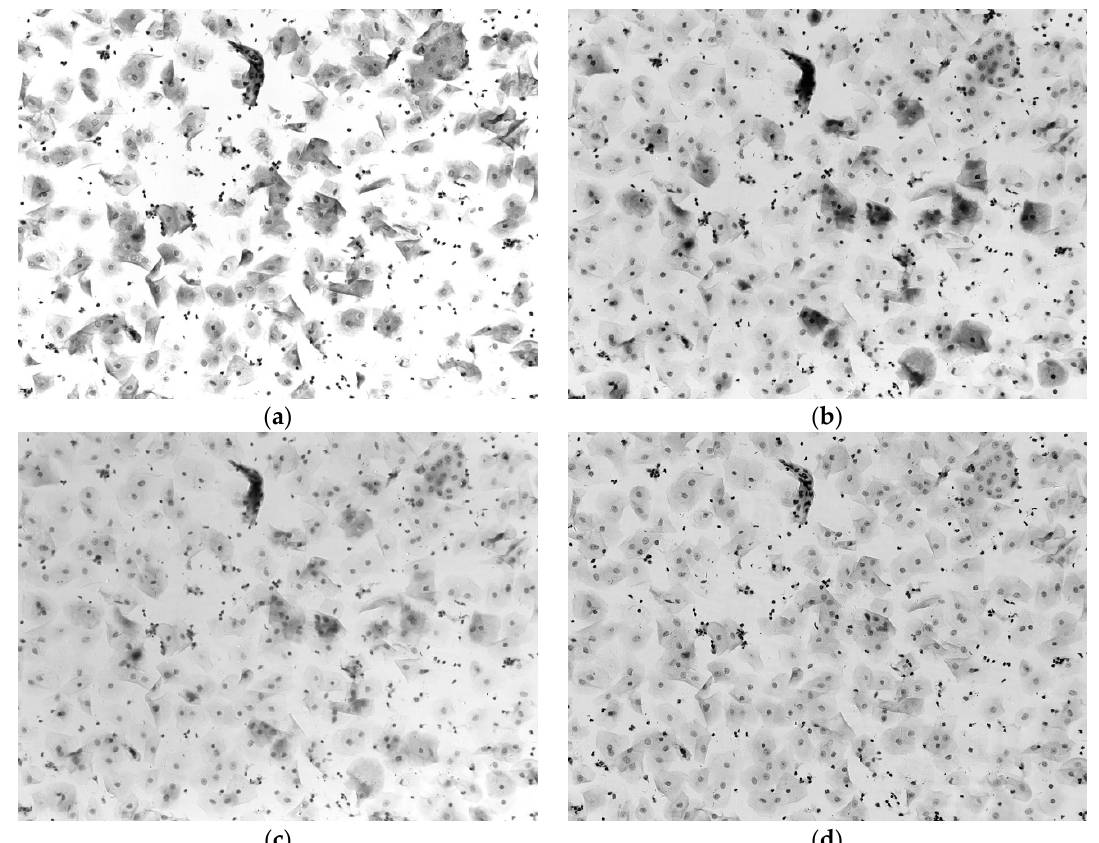
Figure 3. Original images obtained under monochromatic light sources; ( a ) the image of the wavelength of 620 nm, ( b ) the image of the wavelength of 520 nm, ( c ) the image of the wavelength of 460 nm, ( d ) the image of the wavelength of 570 nm.